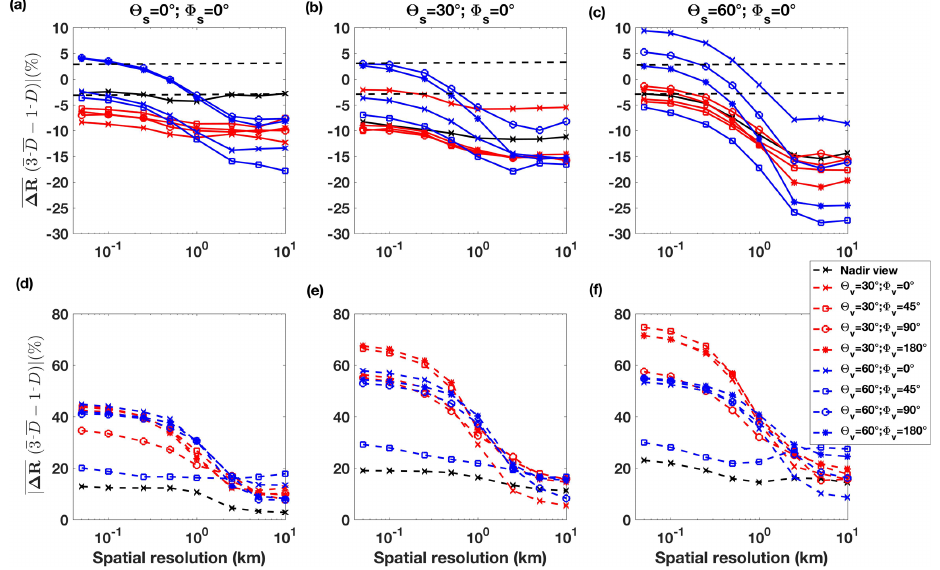
(cid:12) (cid:12) Figure 9. Arithmetic ( (cid:49)R ) and absolute ( (cid:12) (cid:49)R (cid:12) ) differences between 3-D and 1-D reflectances at 2 . 13µm, relative to the 3-D reflectances in percentage, estimated with Eqs. (1) ( a , b , c ) and (2) ( d , e , f ) as a function of the spatial resolution. Each line is for a different pair of viewing zenith and azimuth angles (cid:50) v and (cid:56) v , and each panel is for a different solar zenith angles (cid:50) s . The horizontal dashed lines represent the MODIS reflectance measurement uncertainty of 3% (Xiong et al., 2005, 2017).